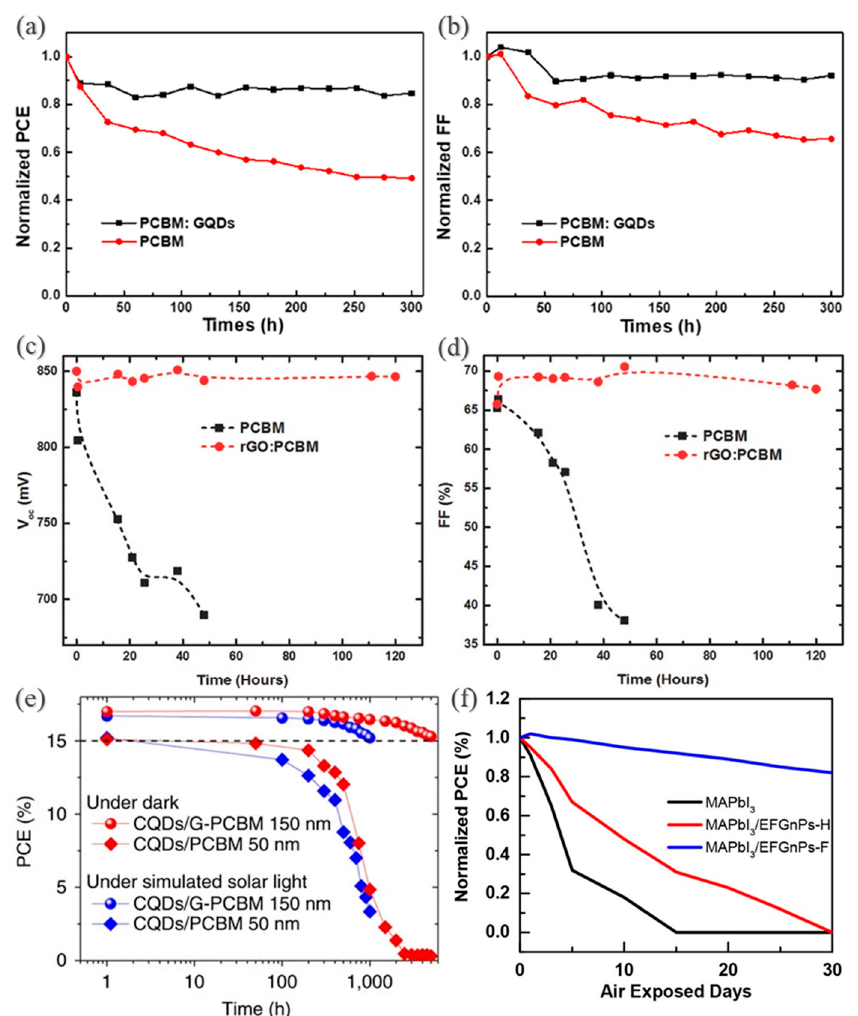
Figure 7. Stabilities of PSCs with ETLs of PCBM and PCBM-GQD under continuous simulated solar illumination in air with ~45% relative humidity [70]: ( a ) Normalized PCE, ( b ) normalized fill factor (FF) (republished with permission from Elsevier); Stabilities of PSCs with ETLs of PCBM and PCBM-RGO under continuous simulated solar illumination in ambient air with ~50% relative humidity [72]: ( c ) Voc, ( d ) FF (republished with permission from Wiley-VCH; ( e ) Stabilities of sealed PSCs under simulated solar light (AM 1.5G) and dark conditions in ambient air [71] (republished with permission from Springer Nature); ( f ) Stabilities of unsealed PSCs under simulated solar light (AM 1.5G) and dark conditions in ambient air with ~50 relative humidity [78] (republished with permission from American Chemical Society).